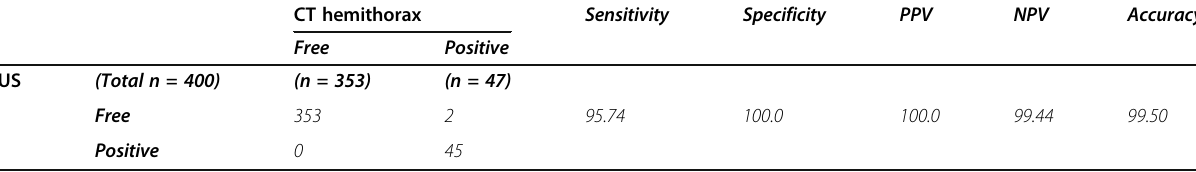
Table 3 Results of chest US in comparison to the CT chest of the chest in detect traumatic pneumothorax CT hemithorax